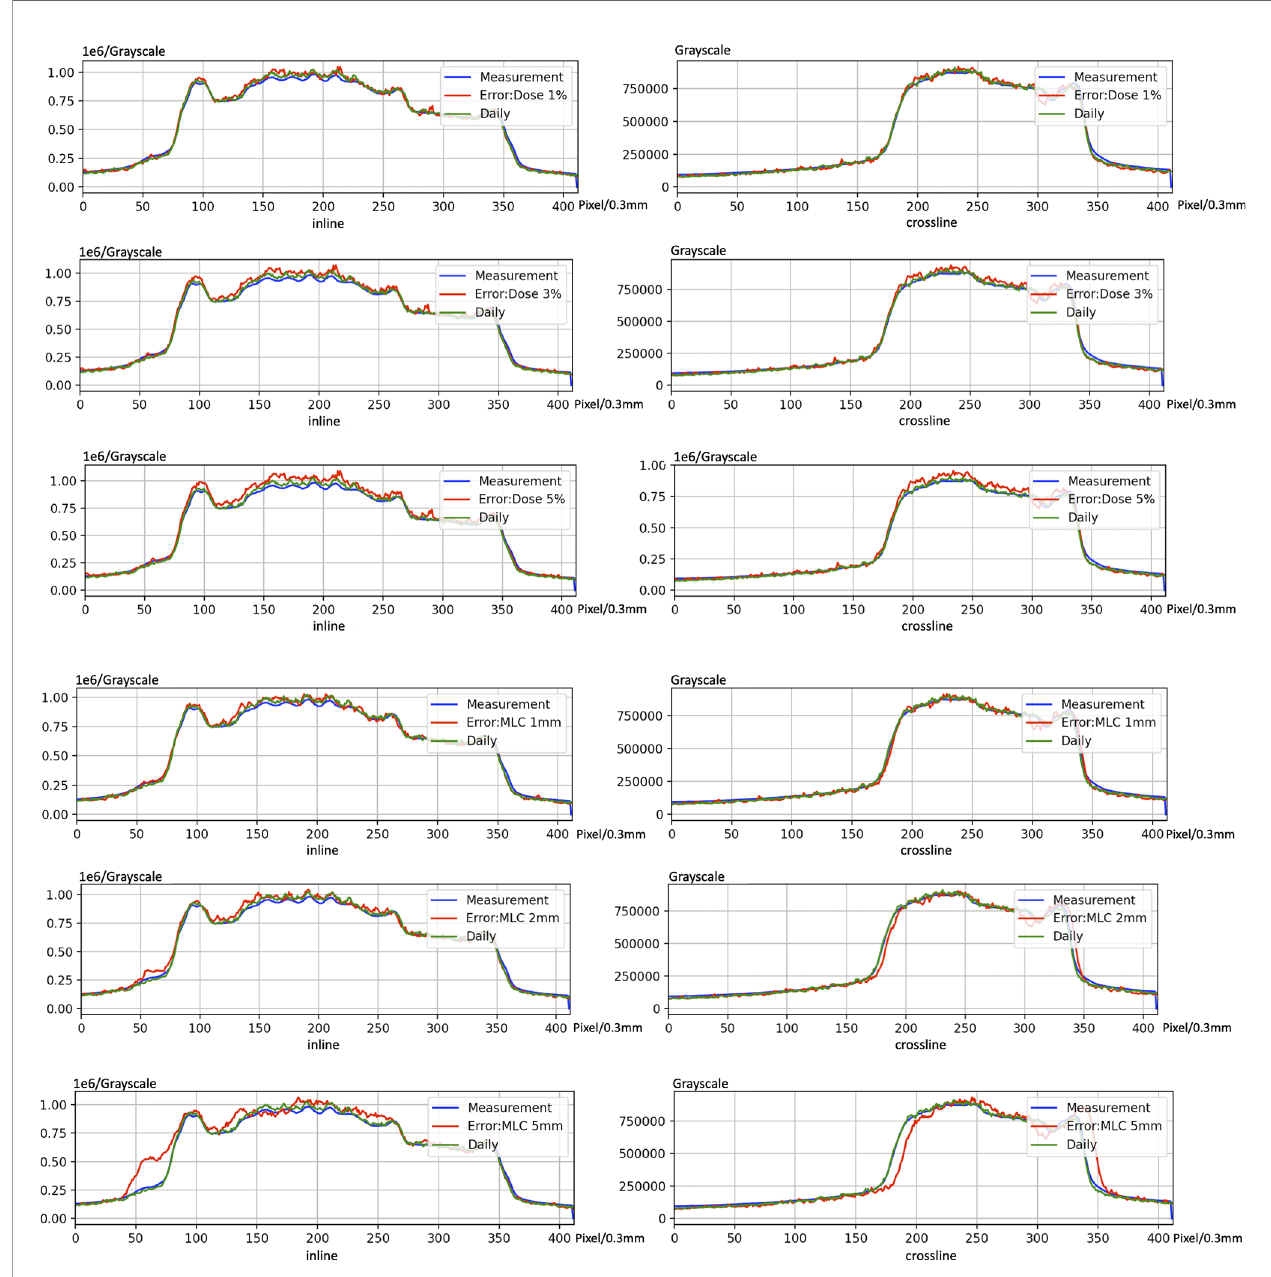
FIGURE 11 | An example of introducing error on electronic portal image device (EPID)-based in vivo dosimetry during